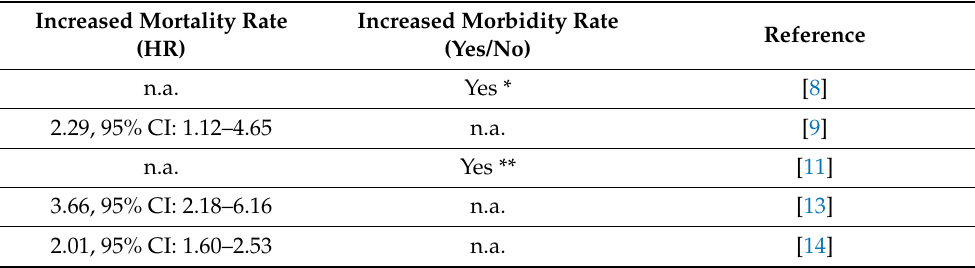
Table 1. List of studies reporting increased mortality and/or morbidity in azoospermic men. Increased Mortality Rate